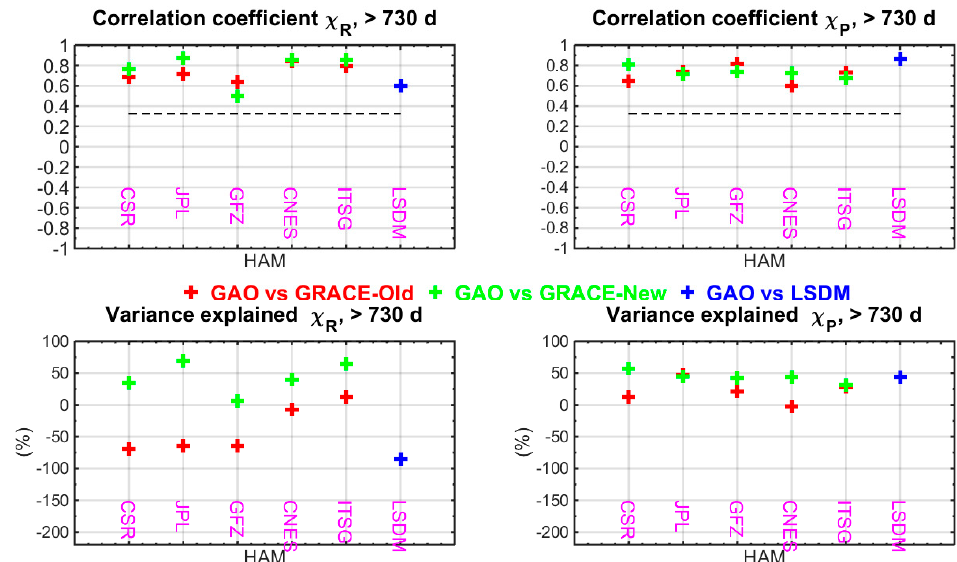
Figure 12. Correlation coe ffi cients of χ R and χ P parts of long-term ( > 730 days) non-seasonal variation between GAO and HAM computed from GRACE solutions and the LSDM and the percentage of variance in GAO explained by HAM functions. The critical value of the correlation coe ffi cient for 25 independent points and a confidence level of 0.95 was 0.34. The standard error of the di ff erence between two correlation coe ffi cients for 25 independent points was 0.30.